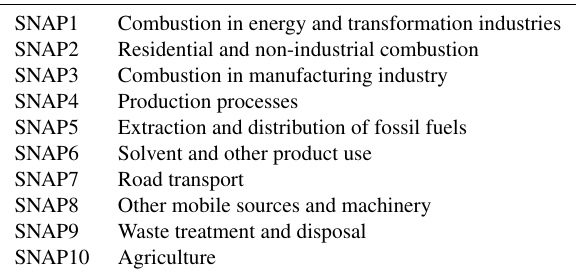
Figure 1. Annual UK PM 2 . 5 emissions by SNAP sector as specified in the NAEI (for year 2012), with each sector split into primary OA (HOA or SFOA), EC, and remaining PM following Kuenen et al. (2014). Source: Ots et al.